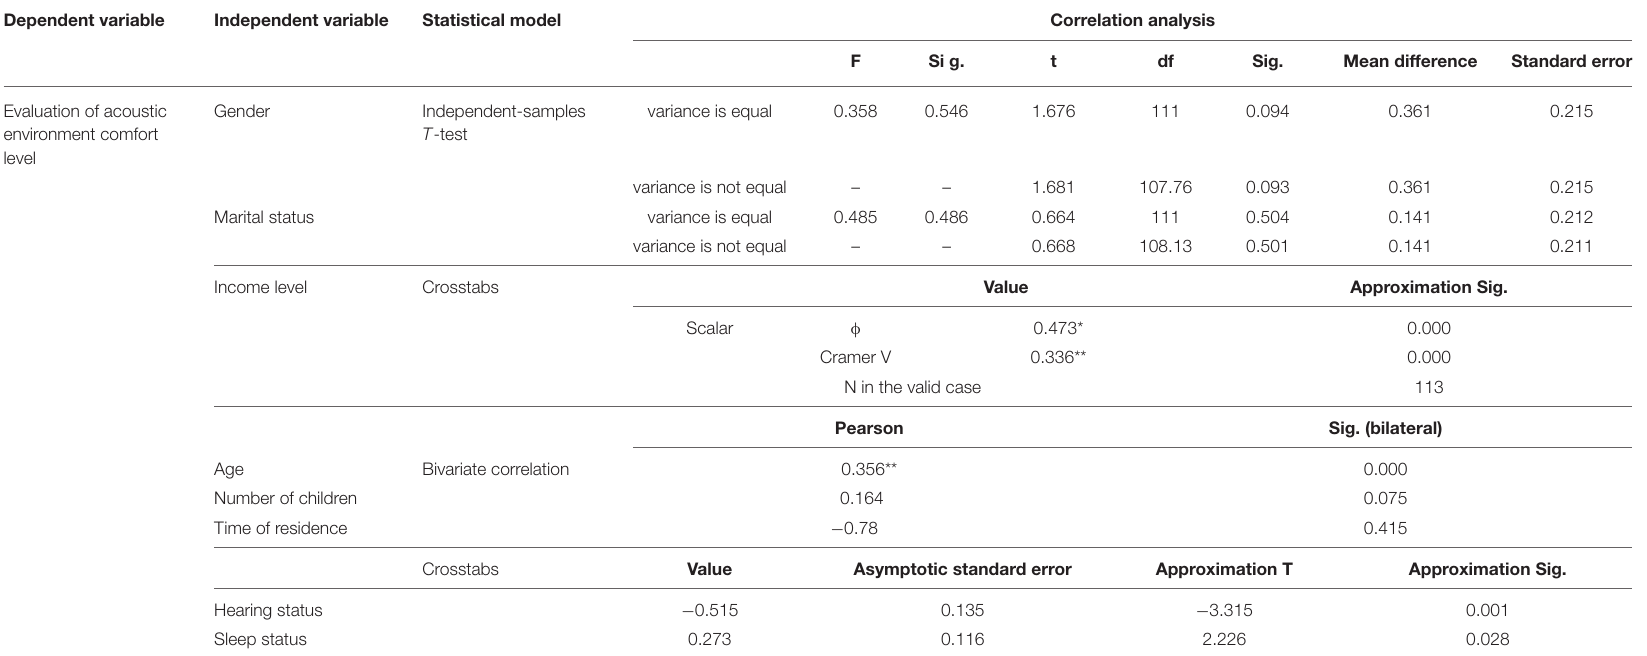
TABLE 4 | Correlation analysis of evaluation of acoustic environment comfort level and social